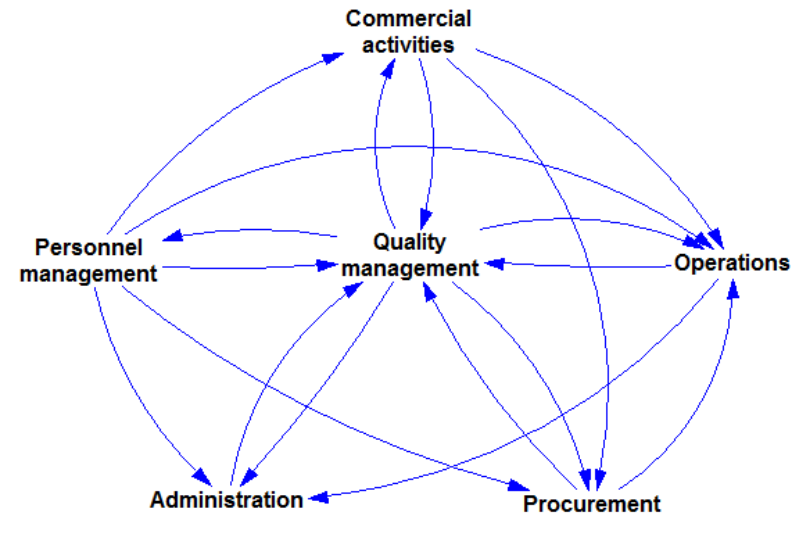
Fig. 1. General model of internal processes of 3PL (developed by the